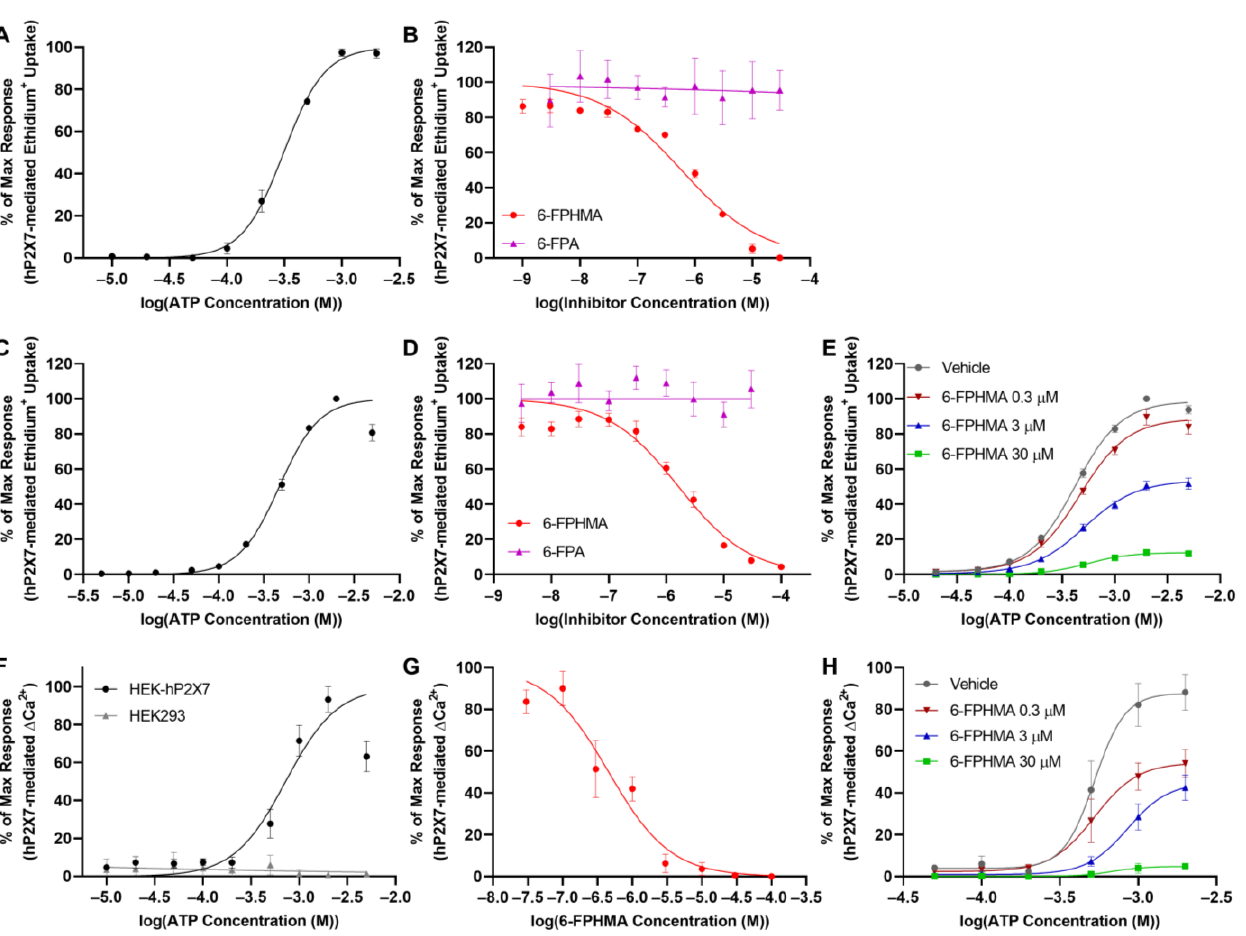
Figure 2. 6-FPHMA inhibits human (h) P2X7-mediated dye uptake and Ca 2+ responses in a non-competitive manner. ( A , B ) RPMI8226 or ( C – E ) human embryonic kidney (HEK)293 cells stably transfected with hP2X7 (HEK-hP2X7) were pre-incubated ( A , C ) alone (5 min) or ( B , D , E ) with 6-FPHMA, 6-FPA or dimethyl sulfoxide (DMSO) (vehicle) at the concentrations indicated (15 min). Cells were incubated with ethidium + in the absence (basal) or presence of adenosine 5 (cid:48) -triphosphate (ATP) at ( A , C , E ) the concentrations indicated, ( B ) 300 μM or ( D ) 450 μM (5 min). ( A – E ) Ethidium + uptake was assessed by flow cytometry and data normalised to the maximum ATP response in each experiment. ( F ) HEK293 or ( F – H ) HEK-hP2X7 cells, pre-loaded with fura-2-acetoxymethyl ester (Fura-2AM), were pre-incubated ( F ) alone (20 min) or ( G , H ) with 6-FPHMA or DMSO (vehicle) at the concentrations indicated (30 min). Cells were incubated in the absence (basal) or presence of ATP at ( F , H ) the concentrations indicated or ( G ) 720 µ M. ( F – H ) Ca 2+ response traces were normalised to baseline (0–15 s) and the area under the curve from 100 to 180 s was used as a measure of hP2X7- mediated Ca 2+ flux. Responses were normalised to maximum ATP response in each experiment. ( A – H ) Data presented as mean ± standard error of the mean (SEM). ( A – E , H ) n = 5, ( F ) n = 6